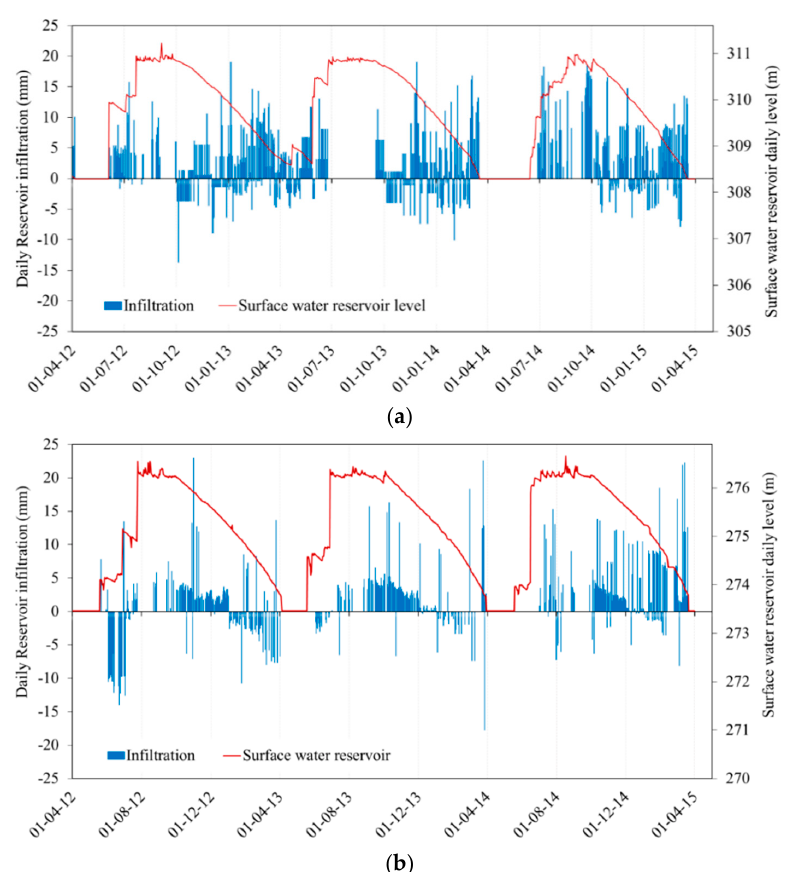
Figure 12. Daily focused recharge according to the evolution of the surface water reservoir (SWR) level of Kierma ( a ) and Mogtédo ( b ).